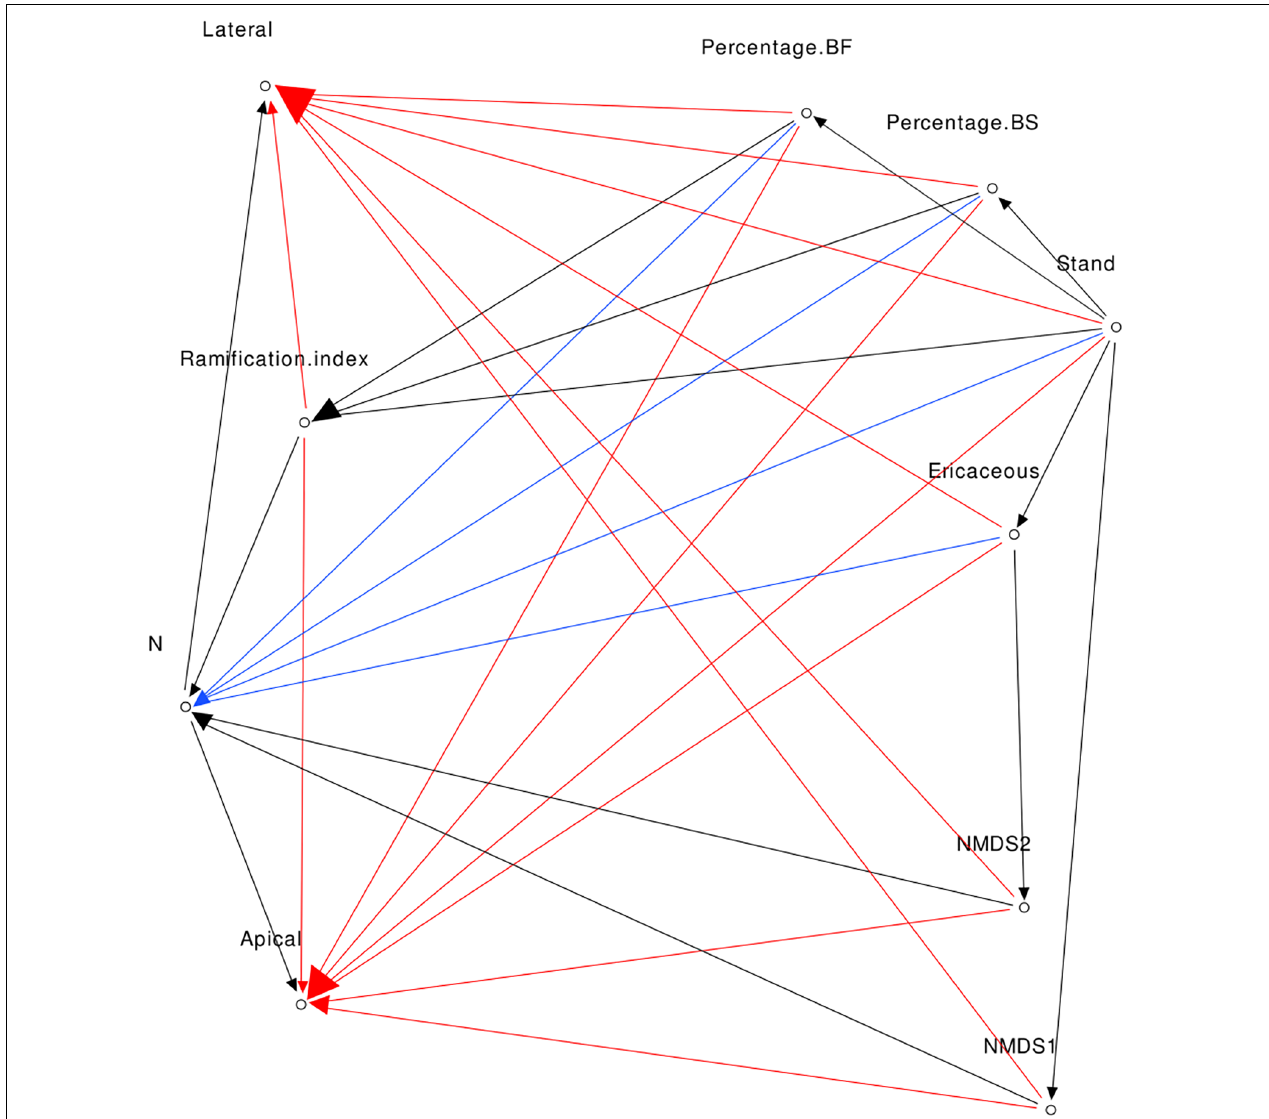
FIGURE 1 | Direct acyclic graph of Mod1 (red, blue, and black arrows), Mod2 (blue and black arrows), and Mod3 (black